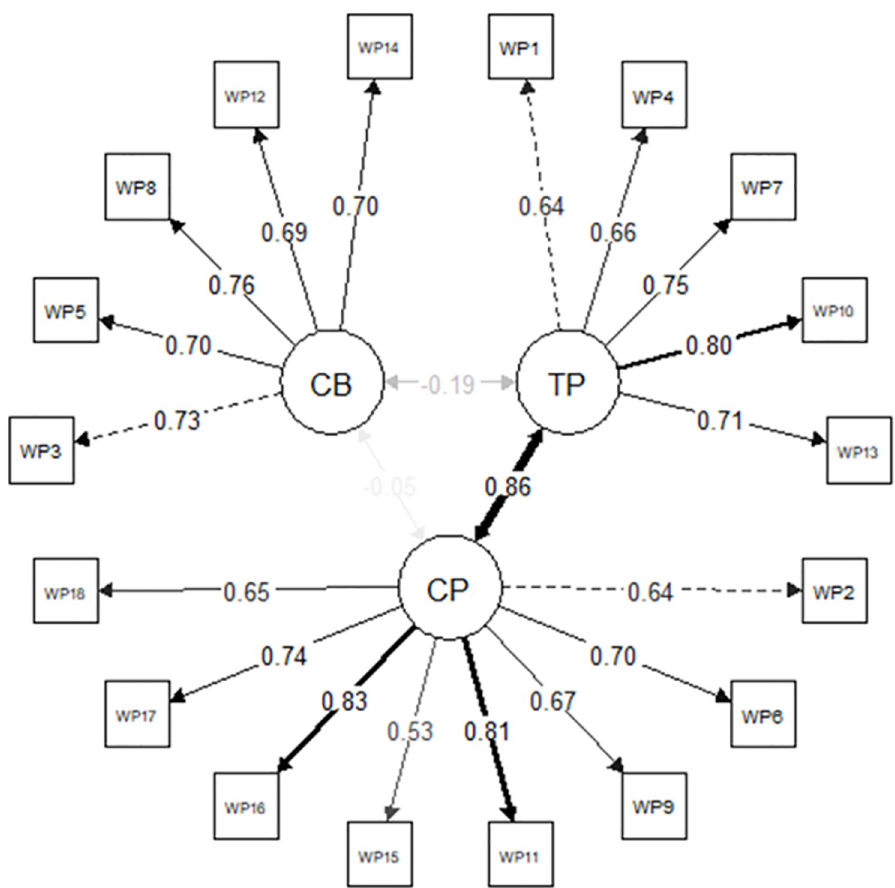
Fig 1. Path Diagram of 3F model. CB = counterproductive work behaviors, TP = task performance, CP = contextual performance.